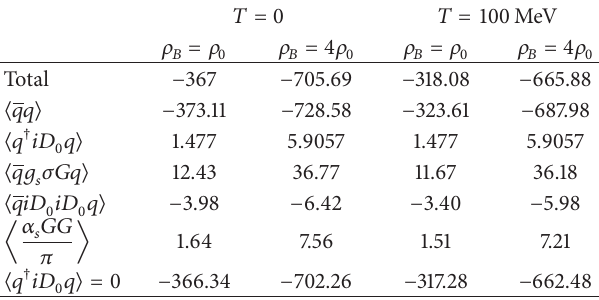
Table 2: The following table gives the values of mass shift of vector mesons 𝐵 ∗ (in MeV units) due to individual condensates at temperatures 𝑇 = 0 and 100MeV. For each value of temperature the values are tabulated for baryon densities 𝜌 𝐵 = 𝜌 0 and 4𝜌 0 .